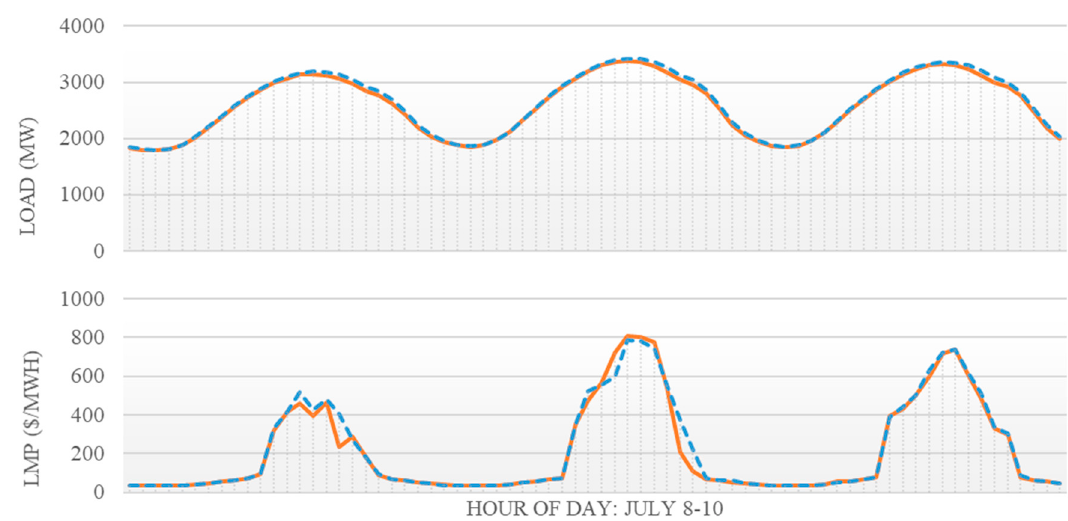
Figure 6. Simulated load (top) and LMP (bottom) curves for Wisconsin Power and Light from 8–10 July 2030 for the baseline (solid line) and high-adoption (dashed line) scenarios. The maximum LMP of the year in either scenario occurs on 9 July 2030. Load shifts to the afternoon in the high-adoption scenario.